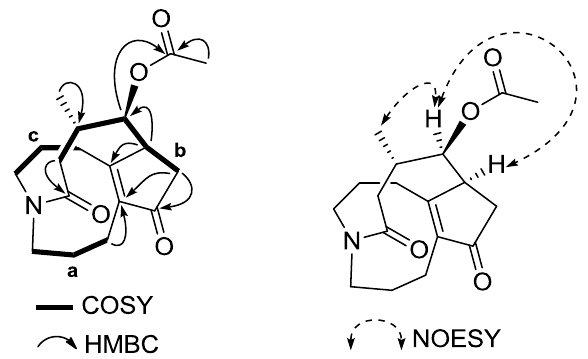
Figure 2. Selected 2D NMR correlations of 1